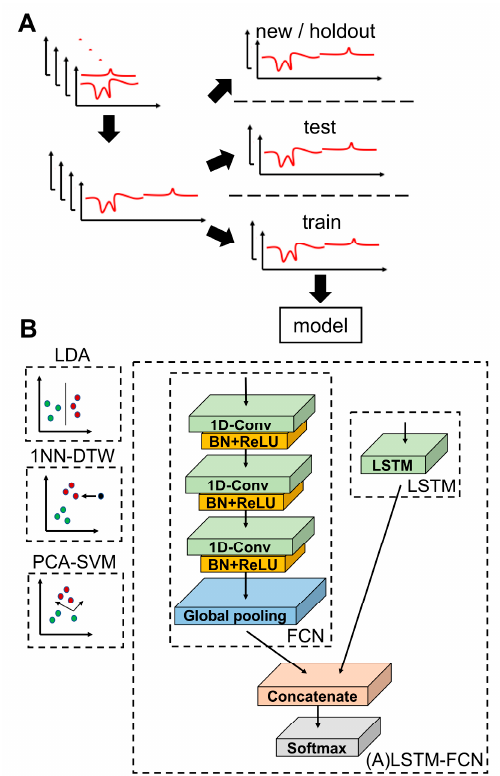
Figure 2 . Data preprocessing and model schematics. ( A ) Schematic of data collection, preparation, and training. ( B ) Schematic representation of each algorithm is shown.